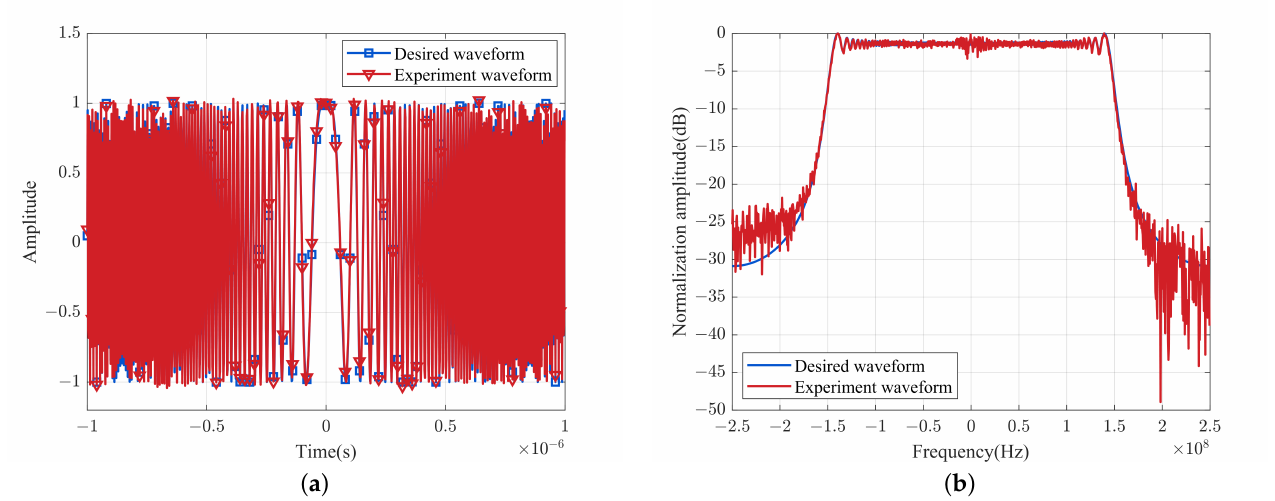
Figure 11. Comparison of the desired synthetic waveform (blue) and the experimental synthetic waveform (red) in radar direction. ( a ) Comparison in the time domain. ( b ) Comparison in the frequency